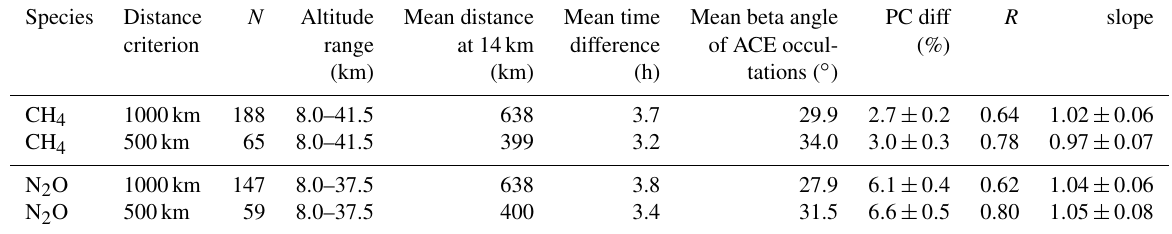
Table 6. Same as Table 4, but for the comparison of the tropospheric species for ACE-FTS v3.5 and PARIS-IR partial columns (2006–2013). Different coincidence criteria are used. Compared here is the maximum distance between the observed air masses at 14km along the line of sight for both